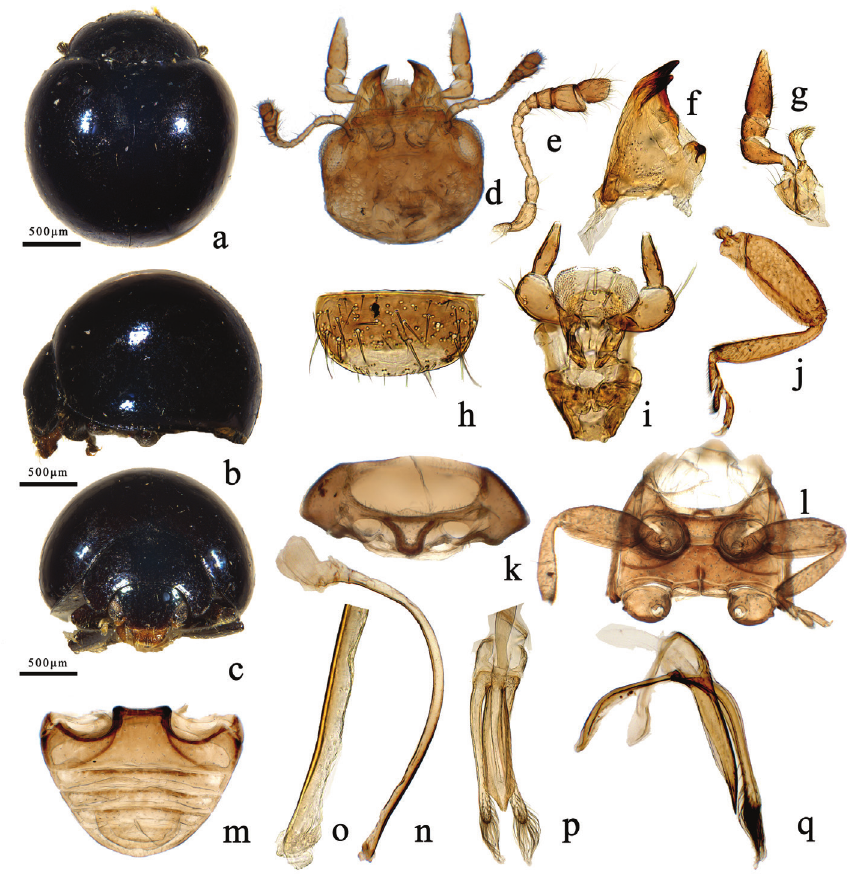
Figure 2. Filipinolotis purpuratorotunda sp. n. a dorsal habitus b lateral habitus c frontal habitus d head, ventral e antenna f mandible g maxilla h labrum i labium j front leg k prothorax, ventral l mesoventrite and metaventrite m abdomen n penis o apex of penis p tegmen, ventral view q tegmen, lateral